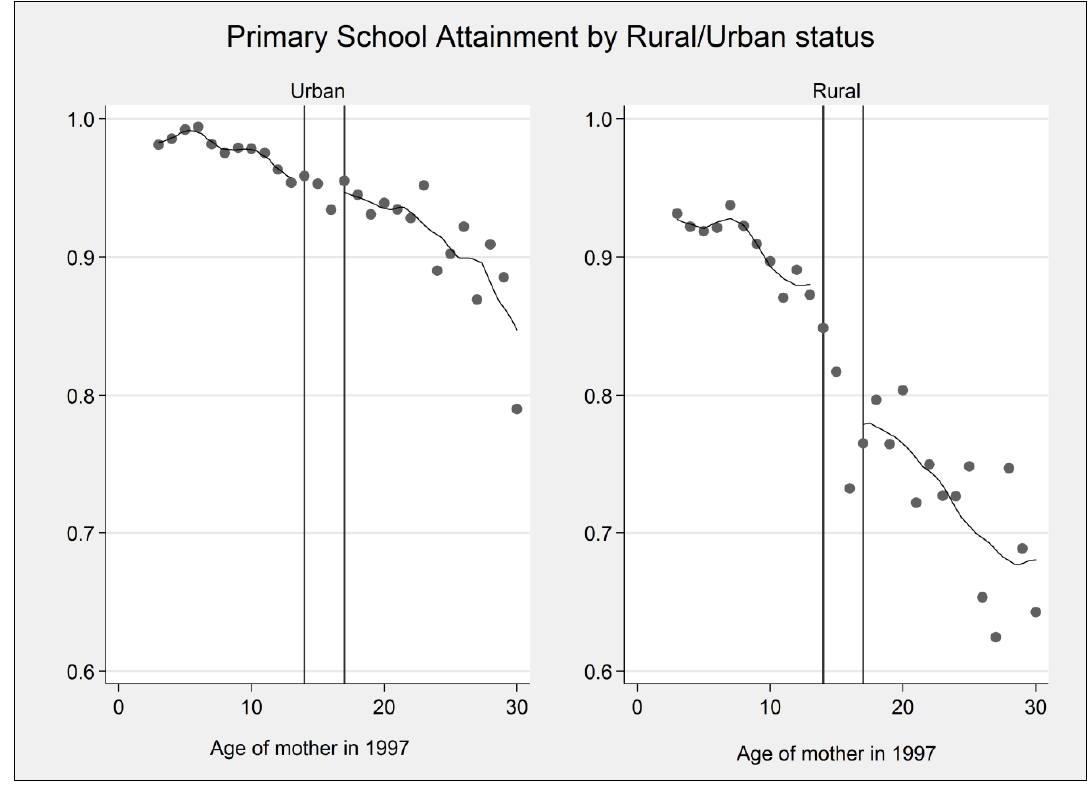
Figure 2. Primary school attainment by urban or rural residence.